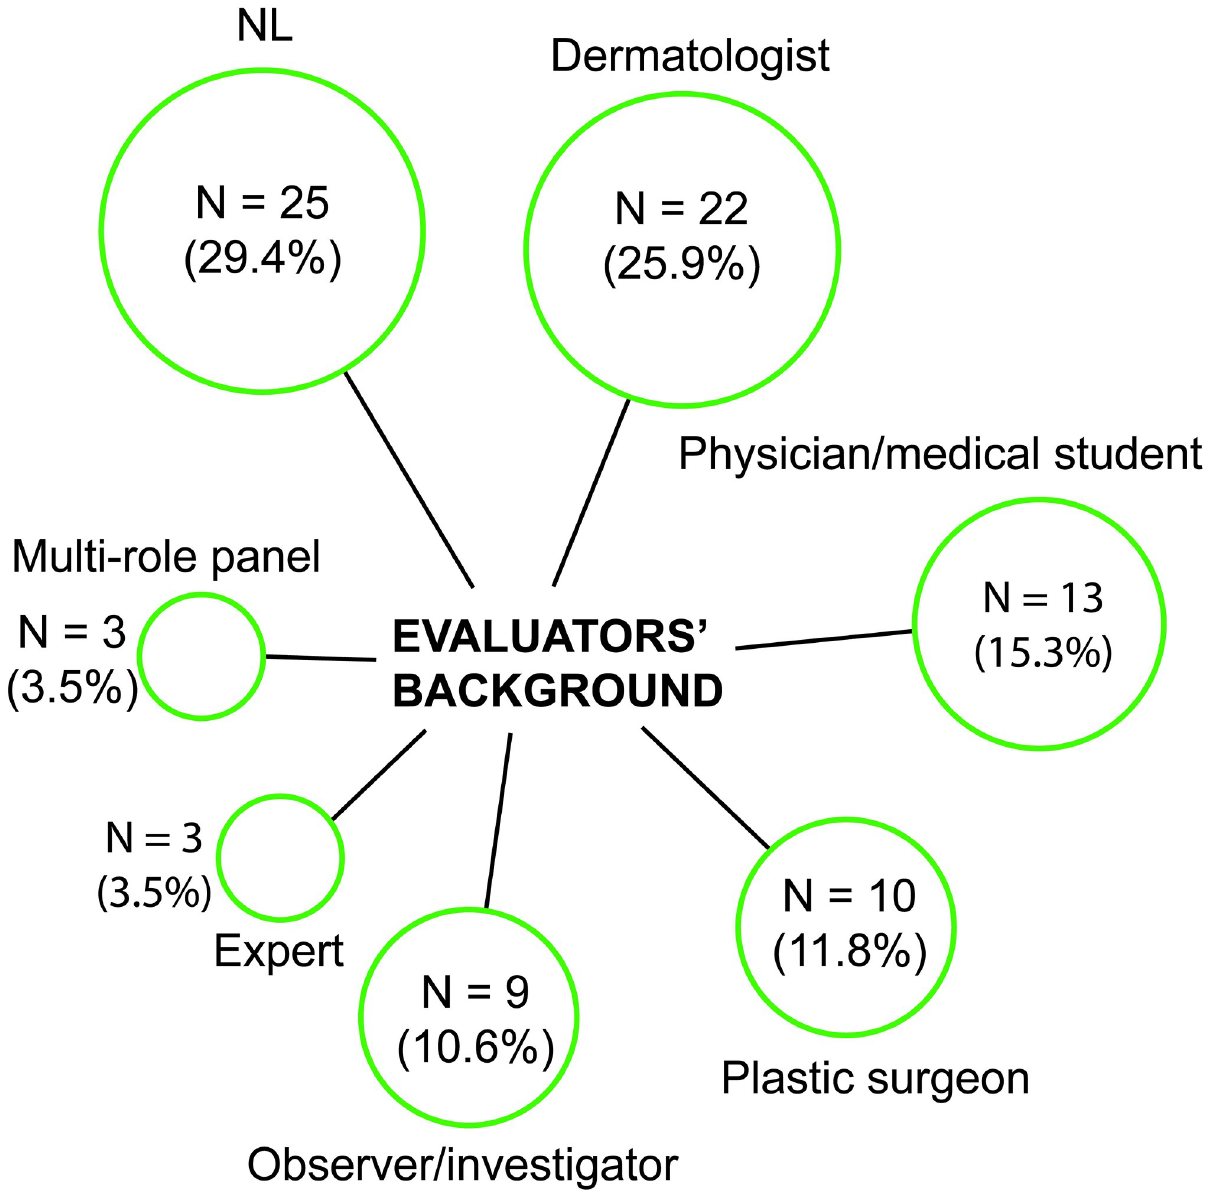
Fig 7. The professional background of the evaluator who performed the primary efficacy assessment. Three studies used a panel of evaluators with different professional backgrounds (compositions were: a physician and a dermatologist; a plastic surgeon and a dermatologist, and a plastic surgeon, medical student, and investigator). Studies with ‘experts’ did not specify the experts’ background. Abbreviations: NL , not